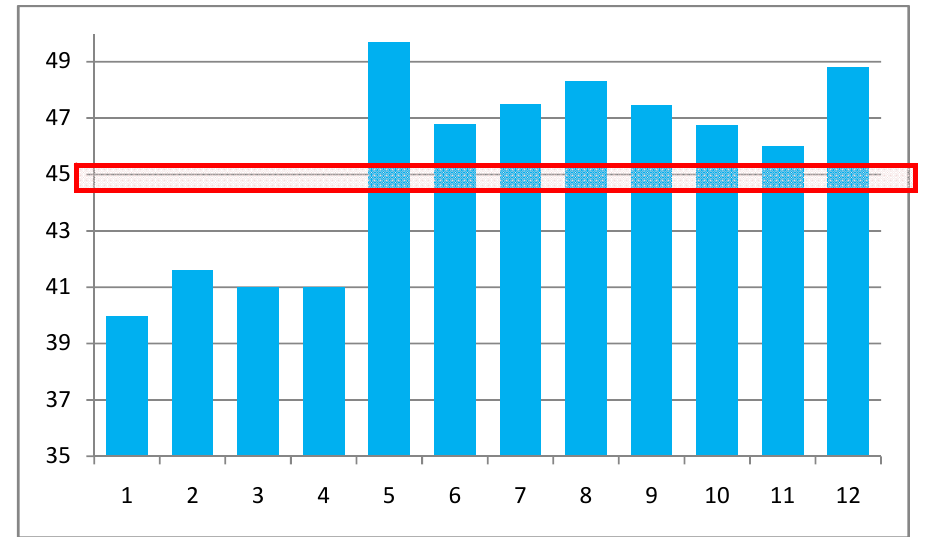
Figure 5. Graphical comparison of a(0) = a(R numbers on the entries are in the right hand column of Table 2. The red box shows the “target” range of